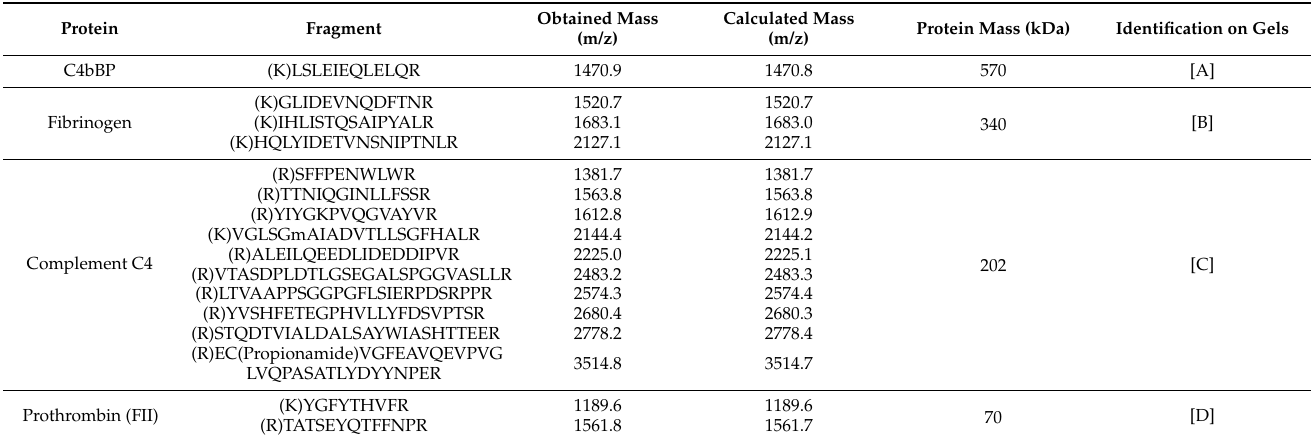
Figure 8. SDS-PAGE 7.5% ( a ) and 5% to 15% ( b ) analysis under reducing conditions of purification of plasma on ANX Sepharose FF with 5 to 25 mM linear CaCl 2 gradient using citrate buffer. Bands marked with an arrow were analyzed by mass spectrometry. The identified proteins were: [A] Complement C4b Binding Protein (C4bBP); [B] Fibrinogen; [C] Complement C4; and [D] Prothrombin (FII). Table 2. Proteins identified by mass spectrometry of fractions collected from plasma purification on ANX Sepharose FF using linear 5 to 25 mM CaCl 2